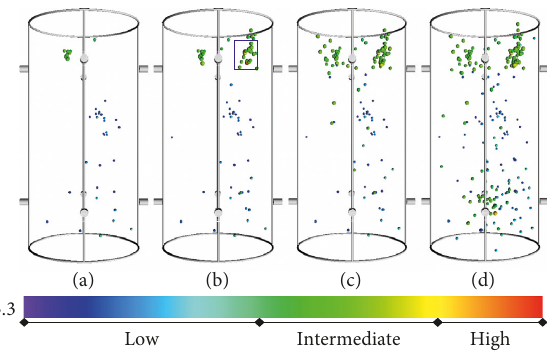
Figure 10: The spatial-temporal distribution of the AE events in Sim10: (a) 0–128s; (b) 0–192s; (c) 0–231 s; (d) 0–535s.